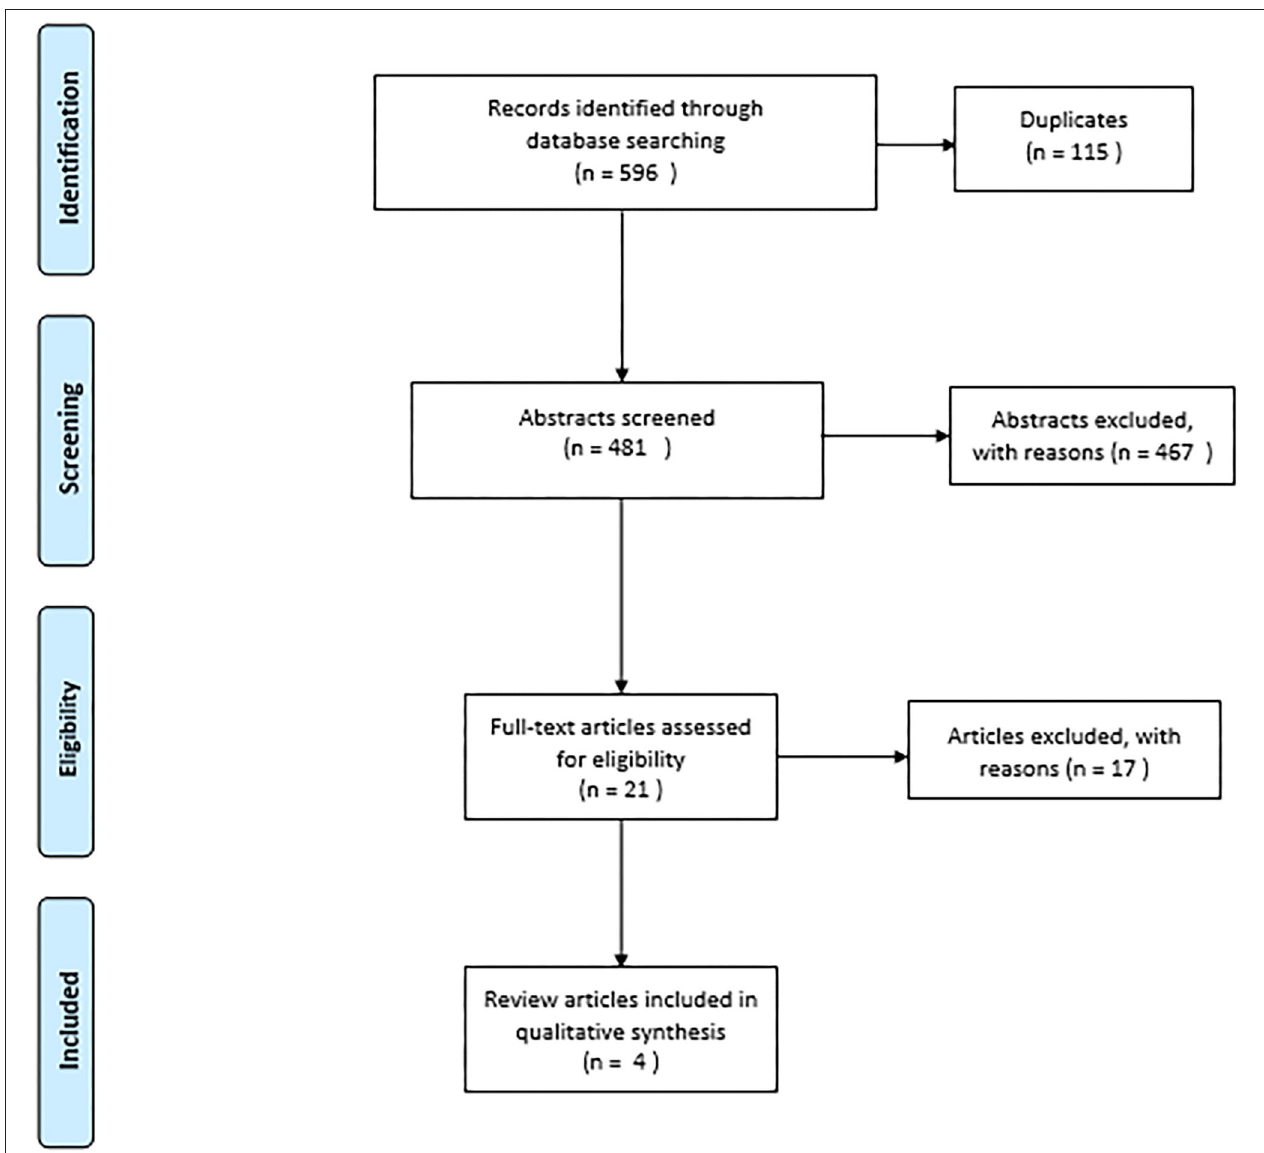
FIGURE 1 | PRISMA flow